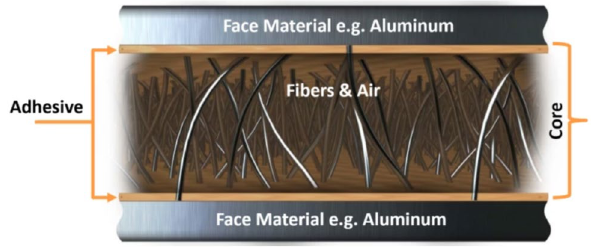
Fig. 1 Conceptual description of the micro-sandwich Hybrix™